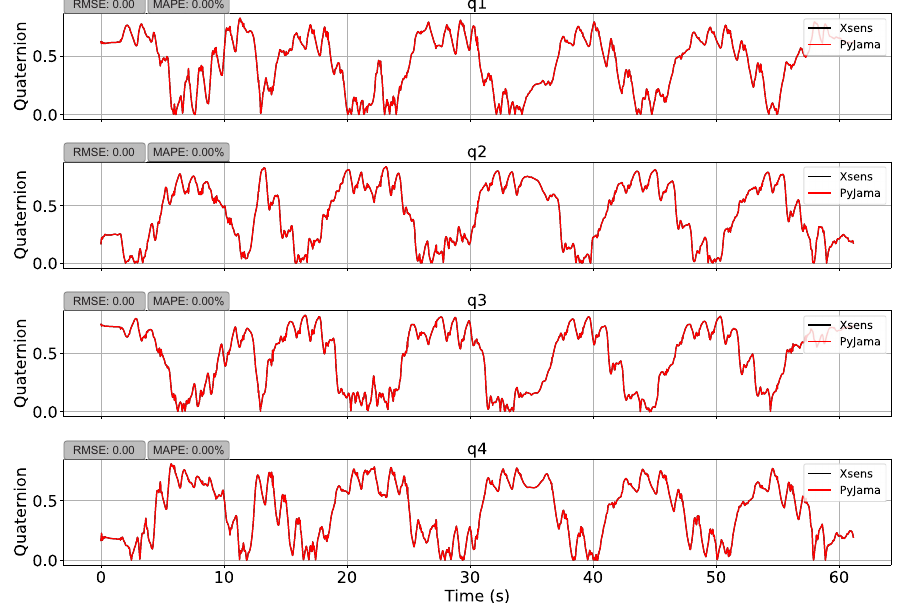
Figure 7. Data manipulation by PyJama. The figure shows the transformation of Xsens quater- nion data to Euler angles, and from Euler angles back to quaternion, using quadrant constraint. The manipulation showed an RMSE of 0.00 and a MAPE of